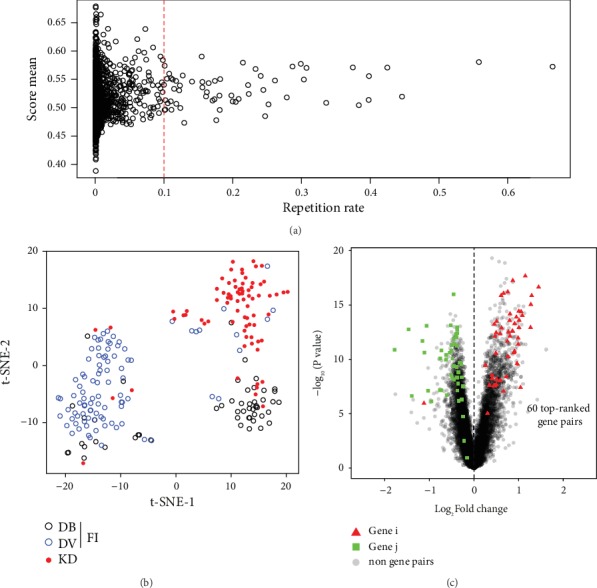
The 60 top-ranked gene pairs. (a) The repetition rate and mean scores of gene pairs in 10,000 resampled train data. Each point represents a gene pair, the red line is the threshold line with a repetition rate of 0.1, and we take a repetition rate greater than 0.1 as the top-ranked gene pairs. (b) Unsupervised t-SNE classification of the discovery set was performed using 60 top-ranked gene pairs. (c) The overlap of differentially expressed genes (KD vs. FI in the discovery set) with 60 top-ranked gene pairs, and Gene i (red triangle) and Gene j (green square) represent the genes to the left and the right of gene pairs, respectively.